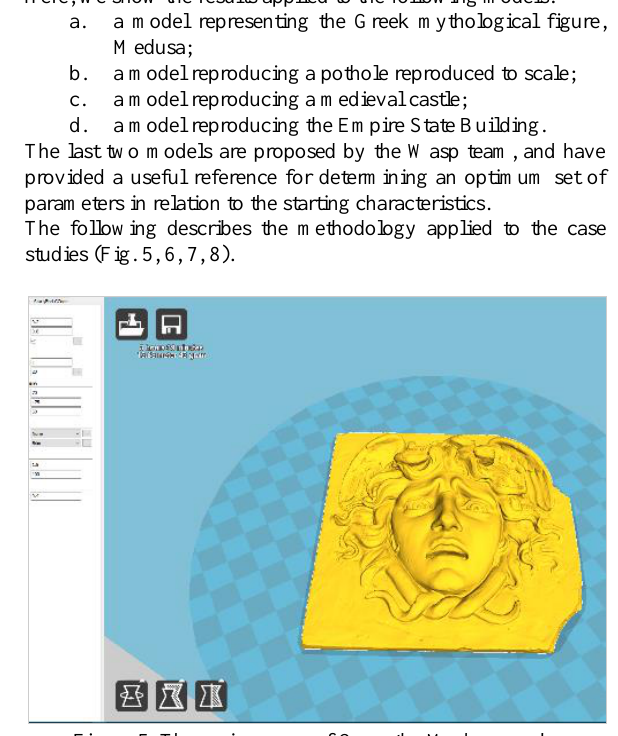
Figure 5. The main screen of Cura; the Medusa mask, horizontal position, normal view mode